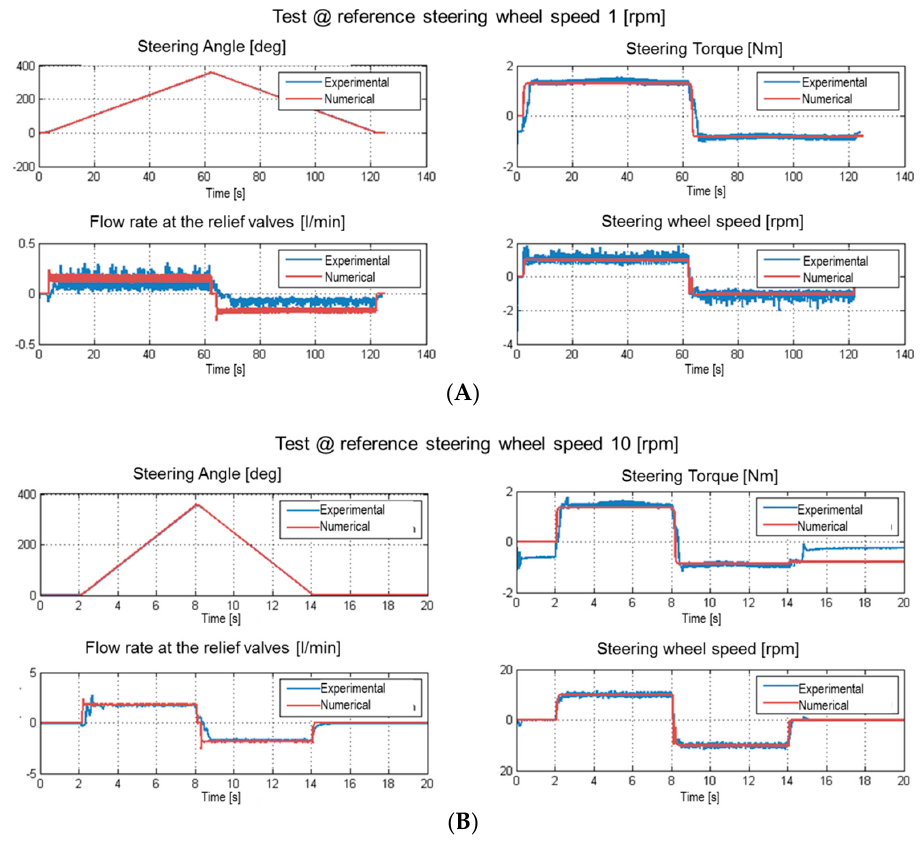
Figure 11. Comparison between the numerical and experimental results at two different speed values of steering input. ( A ) reference speed 1 rpm; ( B ) reference speed 10 rpm.